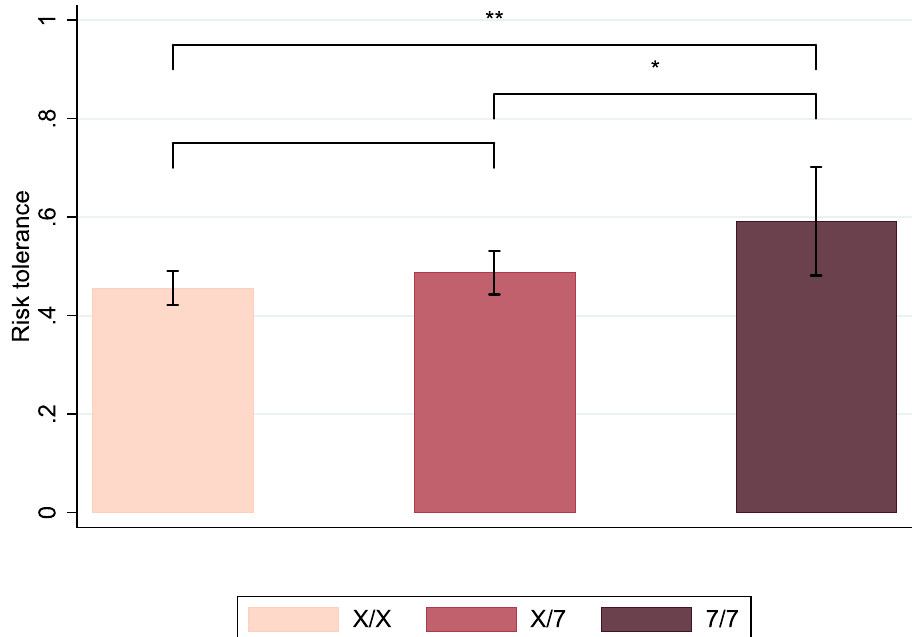
Figure 2. Average level of risk-tolerance by genotype. Note: This figure shows the average level of risk-tolerance between the different genotypes. A higher level of risk-tolerance indicates the choice of a riskier lottery by participants in the lottery choice task. X/X, X/7 and 7/7 represent genotypes, with all alleles not 7R combined into the X allele. Samples from both risky and non-risky areas are pooled. Segments represent 95% confidence intervals. Student’s t -test * p < 0.1, ** p <